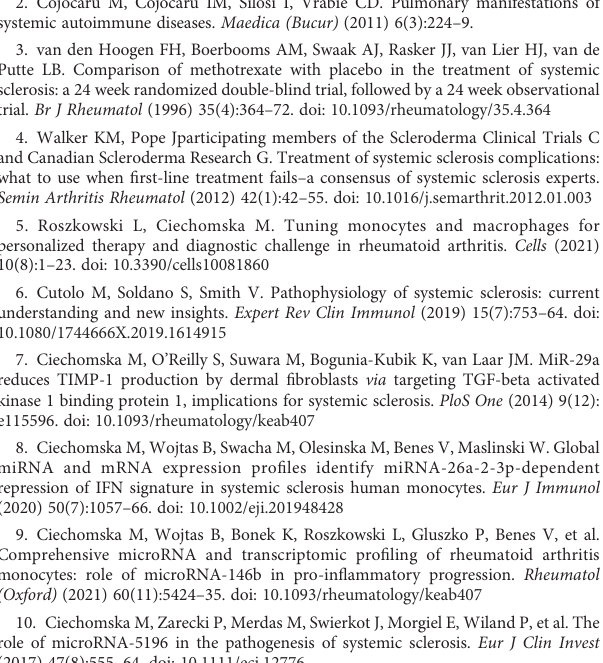
SUPPLEMENTARY TABLE 3 The list of particular miRNAs (miRNA-19b-3p, miRNA-29c-3p, miRNA-374a-